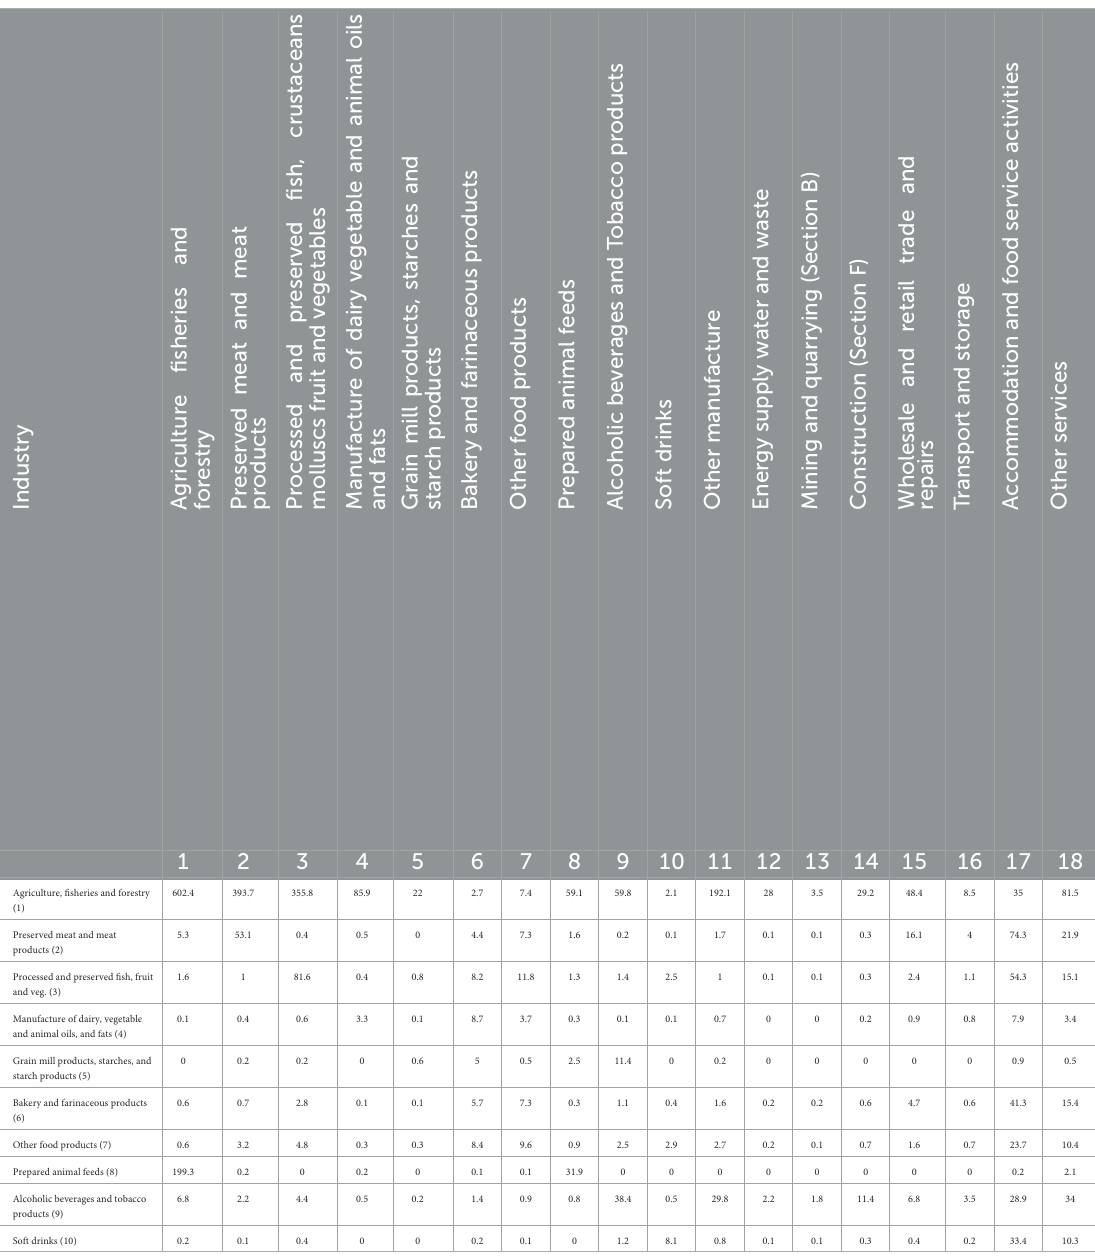
TABLE 1 Aggregated version of the Scottish input–output